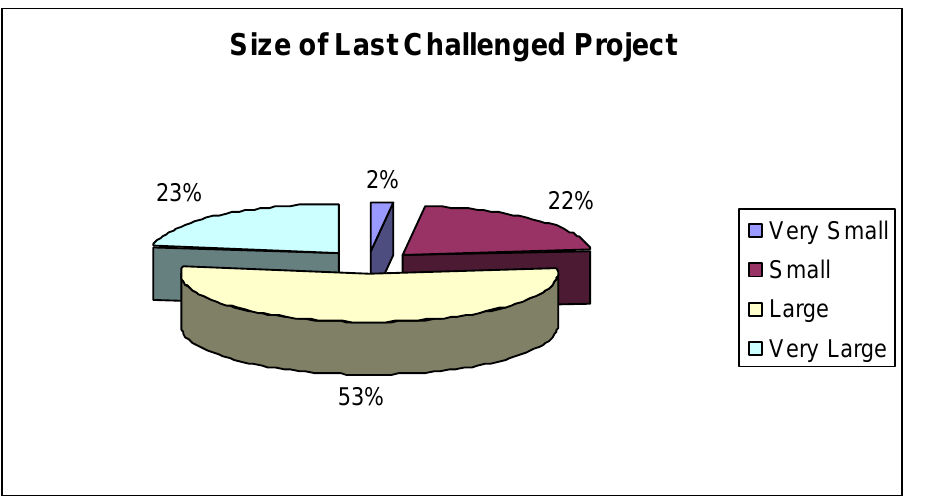
Figure 3: Size of last challenged